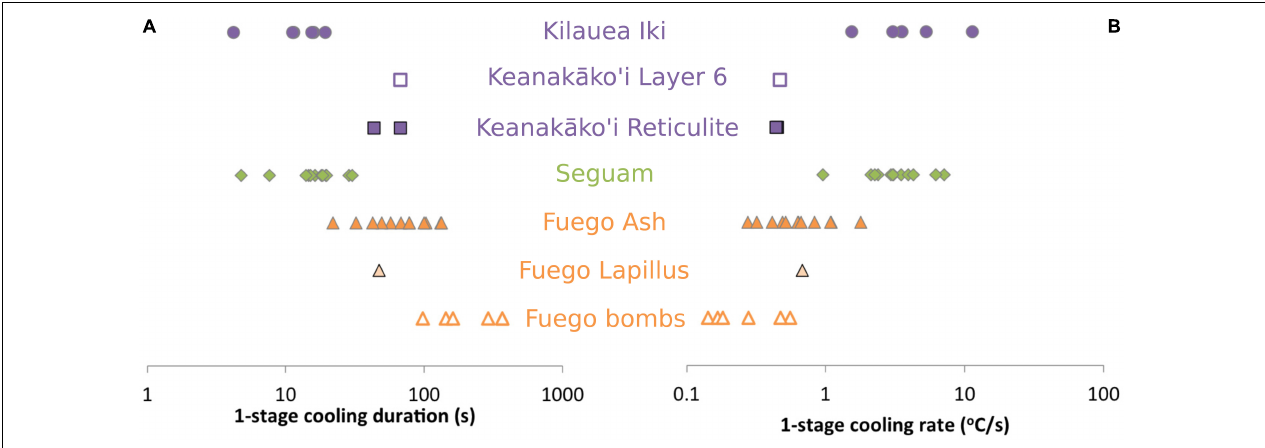
FIGURE 5 | Results of thermal history modeling (A) Best-fit cooling durations obtained by fitting MgO concentration gradients in olivine-hosted melt inclusions to a one-stage linear cooling model. (B) Best-fit cooling rates obtained by fitting MgO concentration gradients in olivine-hosted melt inclusions to a one-stage linear cooling model. Estimated errors on best-fit parameters are provided in the Supplementary Data Tables